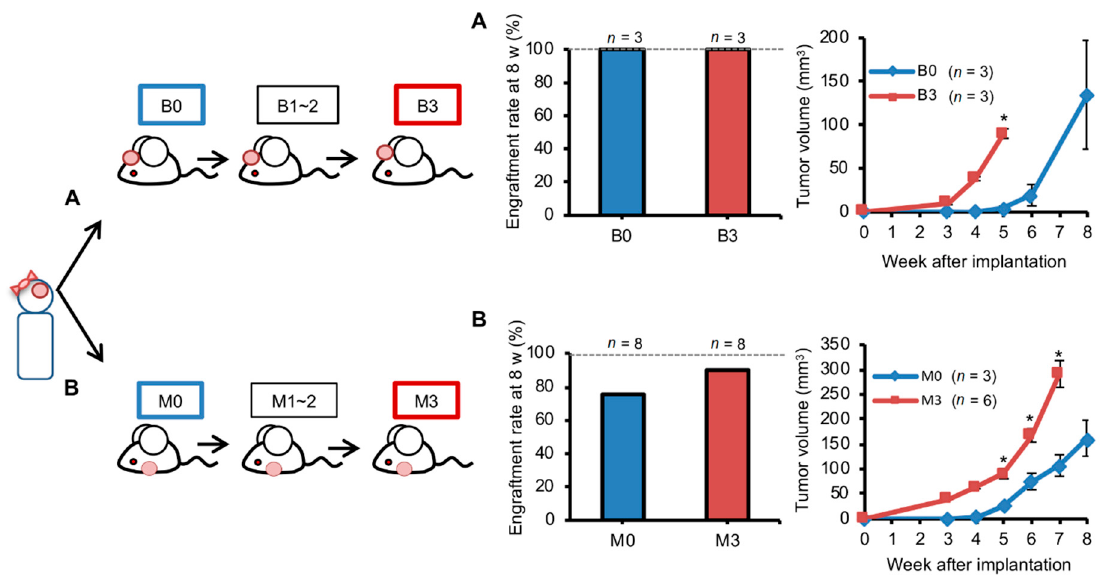
Figure 4. Serial passage facilitates growth of tumors implanted in either brain or mammary fat pad. Brain metastasis of one triple negative breast cancer patient was used for this experiment. Tumor was prepared with the mincing method for implantation (1 µL tumor + 2 µL phosphate-buffered saline)